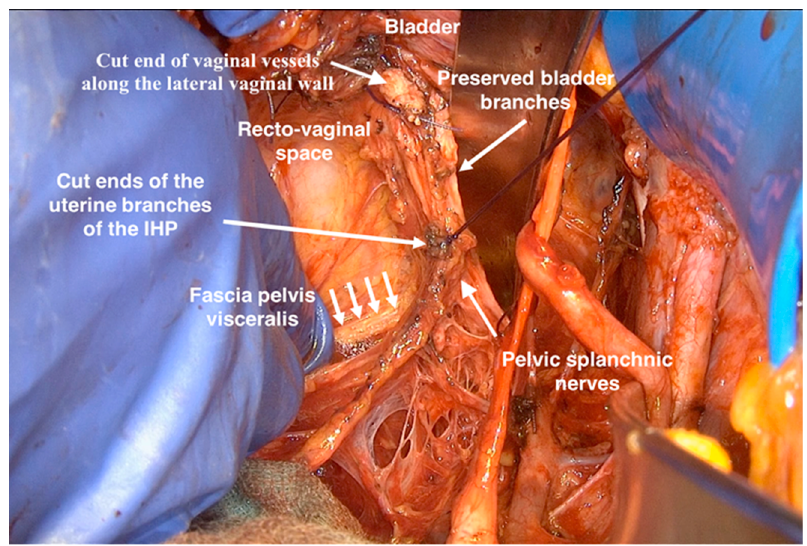
Figure 10. The spared components of inferior hypogastric plexus after radical hysterectomy.